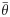
Calculated angular distribution parameters vs. reference distribution parameters for the experimental data.(A) Mean fiber orientation θ¯ vs. mean fiber orientation θ¯m achieved from manual segmentation. (B) Fiber dispersion b vs. fiber dispersion bm achieved from manual segmentation. R2 values are given for the fitted curve (solid, orange) as well as for the ideal curve (dashed, black) with a slope of one. Errorbars represent 95% confidence bounds of fitted parameters.